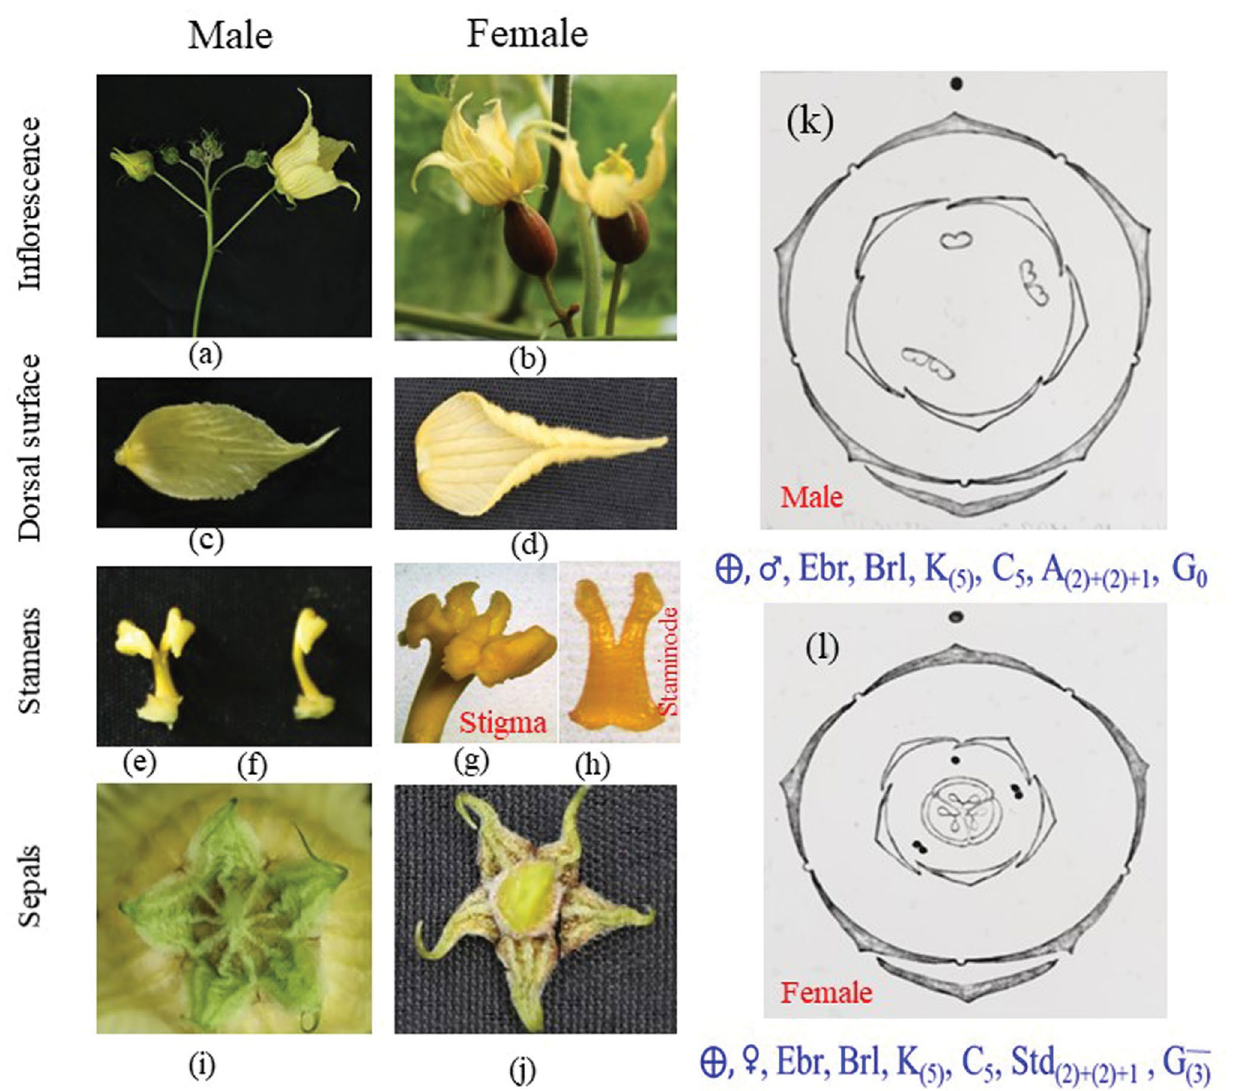
Figure 2. Different parts of Siraitia grosvenorii flowers, male inflorescence (a) ; female flower (b) ; male petal dorsal surface (c) ; female petal dorsal surface (d) ; stamen compound (e) ; simple stamen (f) ; stigma (g) ; compound staminode (h) ; male sepals (i) ; and female sepals (j) . Floral formula of male (k) and female (l) reddish green; 10–15 mm in size, pedicel 4–9 mm and stigma was fully visible and yellowish in color. In wilted stage, color of the ovary was reddish brown, 7–9 mm in size, pedicel 4–7 mm, stigma was fully visible and yel- low in color. At senescent stage, ovary converted into brown in color, 4–6 mm in size, pedicel also 4–6 mm, and stigma was fully visible with blackish yellow in color (Table 2). Receptivity of stigma was also studied and presented in Fig. 5. The bubbling from stigma showed the recep- tivity of stigma (Fig. 5). As per our observation, anthesis stage (full opened) of the female flower bud was found the best stage for the receptivity of pollen grains for fertilization (Fig. 5c). Thus, it is clear that fully open flower stigma has higher receptivity than others, and it is the best stage for fertilization for fruits setting. It could be an immense practical important for manual pollination during commercial cultivation as it is a dioecious plant. In male flower, size, color, length of the pedicel, anther texture, color and availability of pollen grains at different stages have also been observed (Table 2). During male bud development, it was noticed that color of the bud was changed from reddish green to brown during different stages. The length of petiole was also varied, and it was up to 15 mm. Color of the anthers was bright yellow and changed to light yellow at wilted and senescence stage. Pollens were available in fully open male flower, yellow in color, bright and sticky, after that they became black in color at wilted and senescent stage. Thus, it is clear that the stage III (fully open male flower) is best stage for highly viable pollens as per our observation.